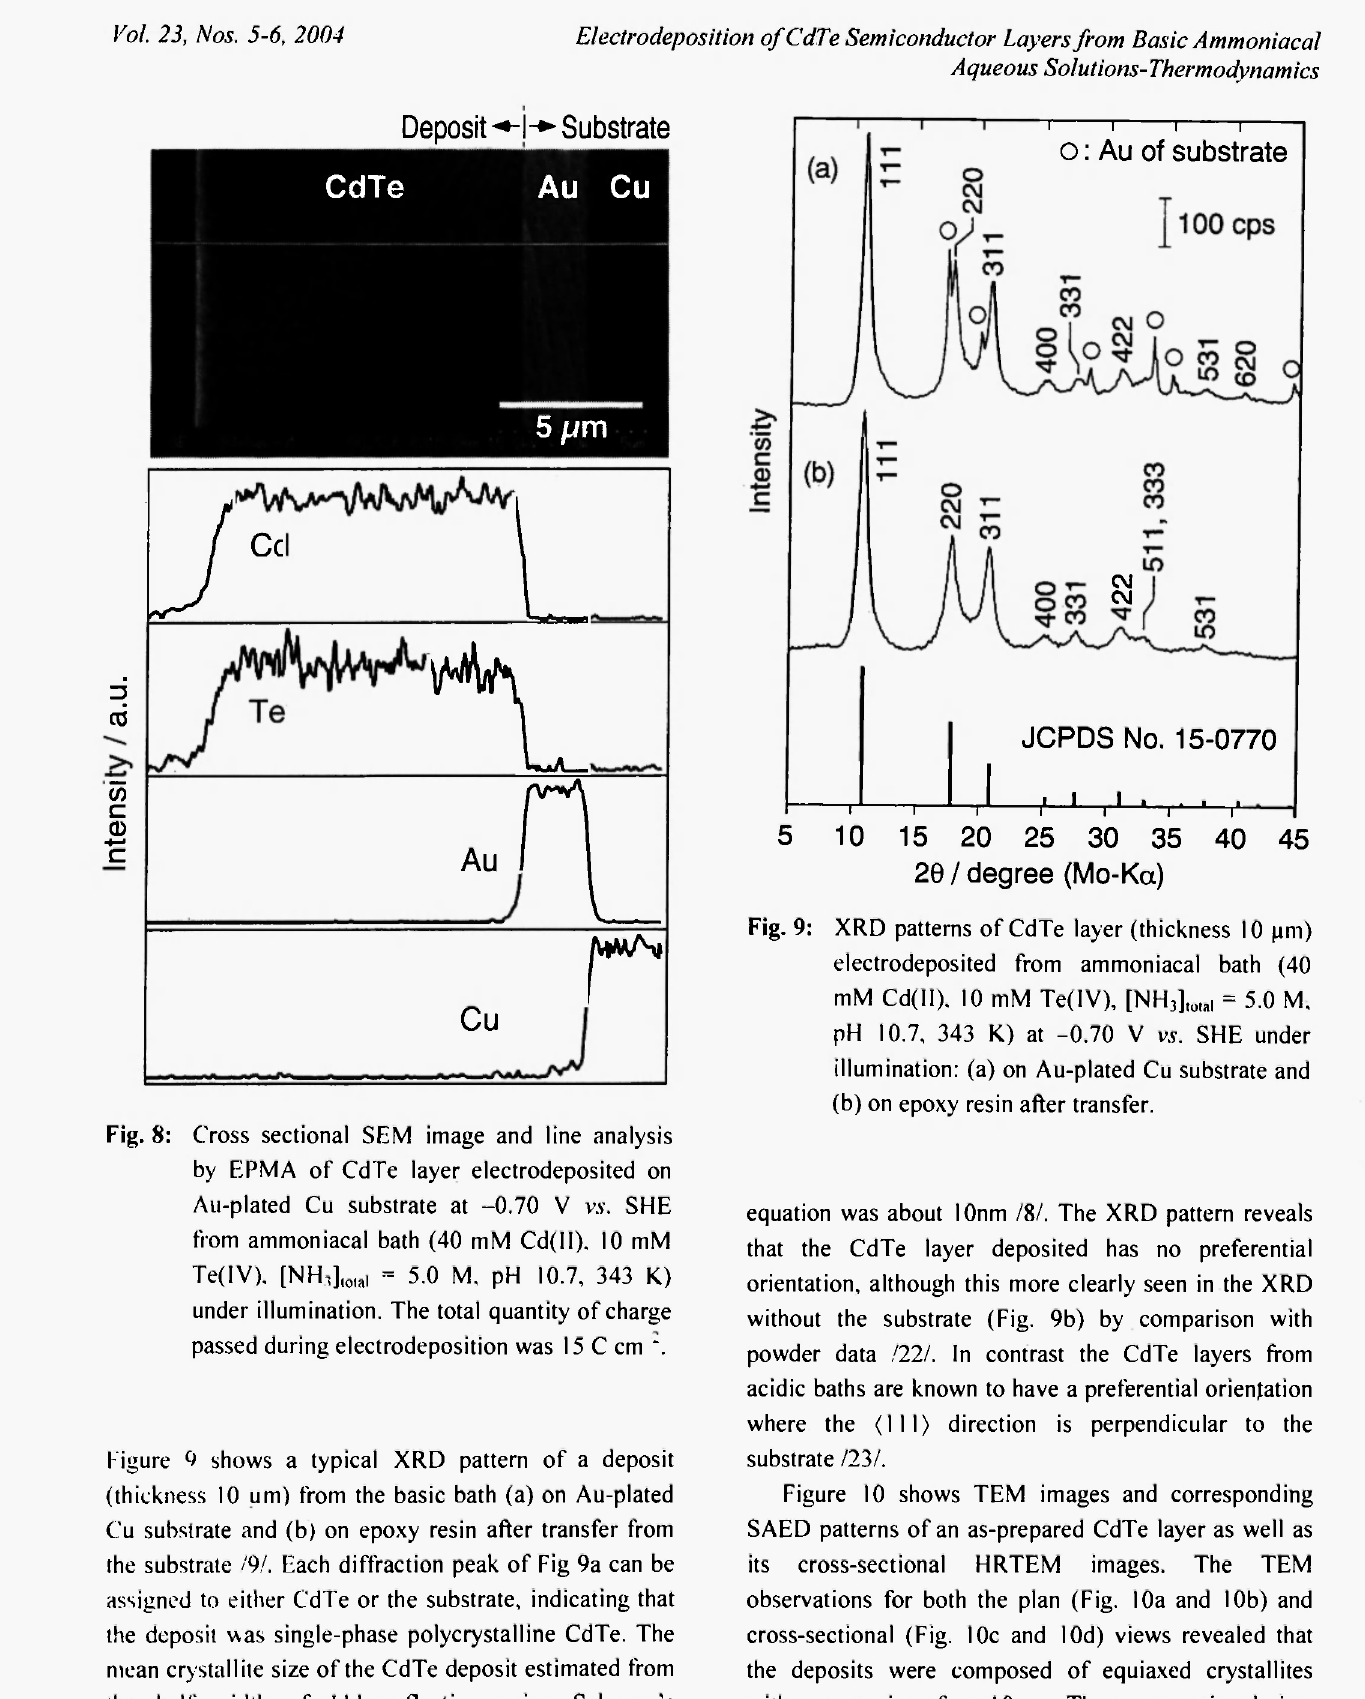
Fig. 9: XRD patterns of CdTe layer (thickness 10 μηι) electrodeposited from ammoniacal bath (40 mM Cd(II). 10 mM Te(IV), [NH 3 ] toml = 5.0 M, pH 10.7, 343 K) at -0.70 V v.?. SHE under illumination: (a) on Au-plated Cu substrate and (b) on epoxy resin after